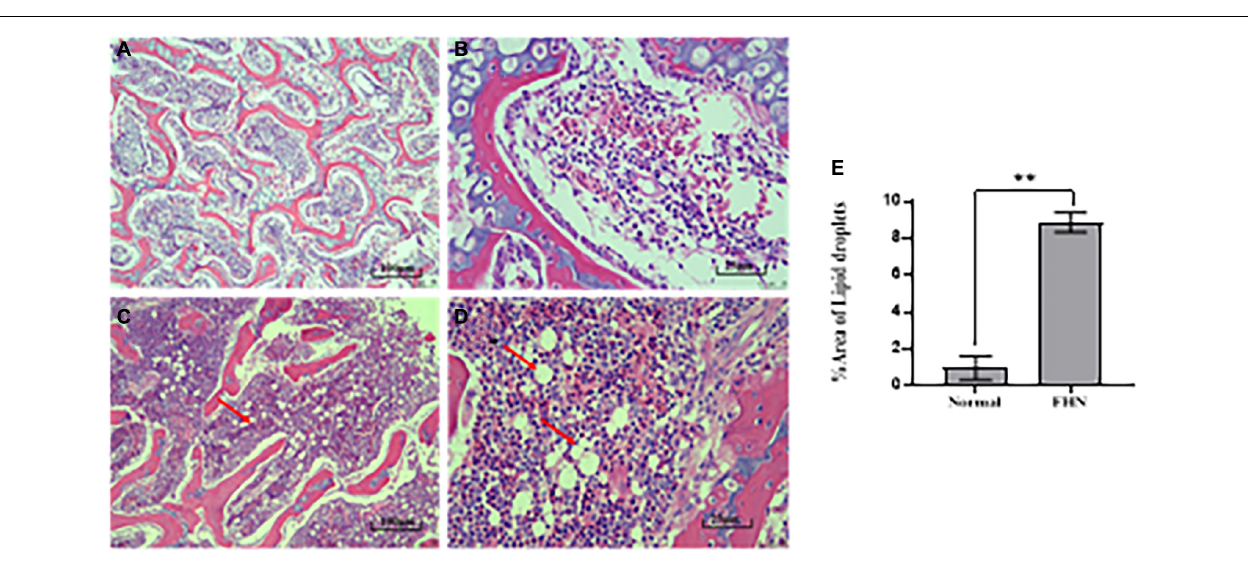
FIGURE 10 | HE staining of the femoral head in the broilers at the age of 5 weeks. Normal broilers: (A,B) ; FHN broilers: (C,D) ; analysis of the area of lipid droplets in the femoral head (E) . The red arrow points to the site where vacuolar degeneration occurred. ∗∗ indicates an extremely significant difference ( P <